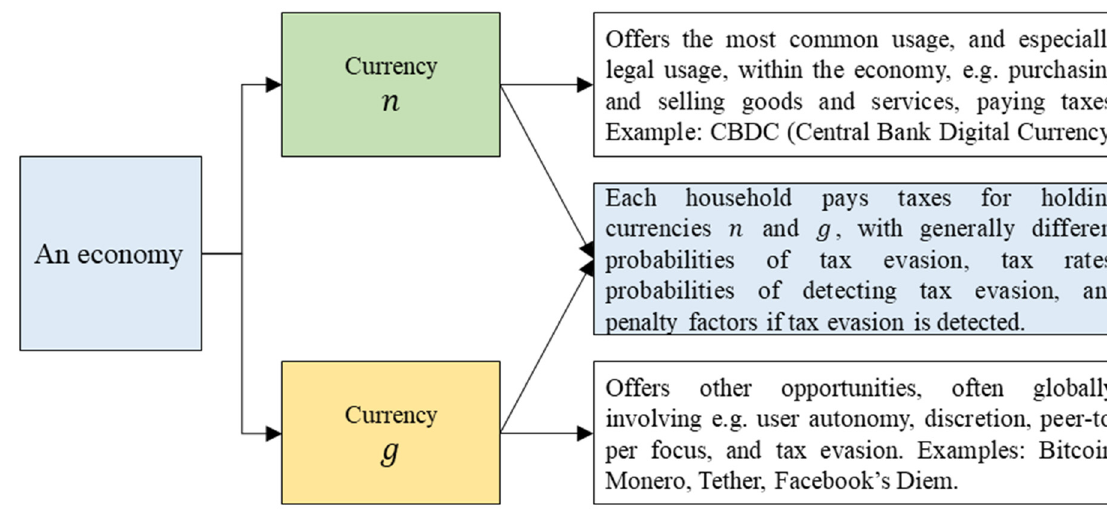
Figure 1. An economy with two currencies 𝑛 and 𝑔 .